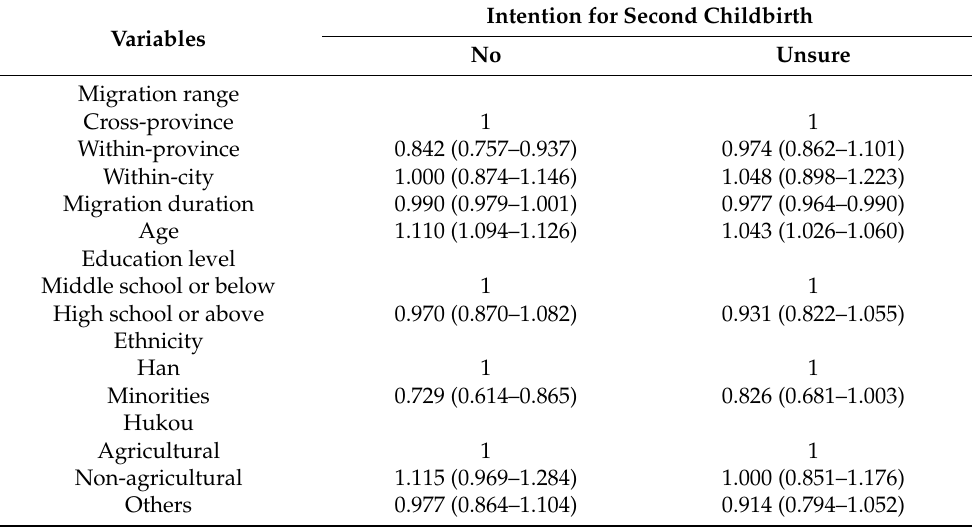
Table 3. Logistic regression analysis of the influencing factors on fertility